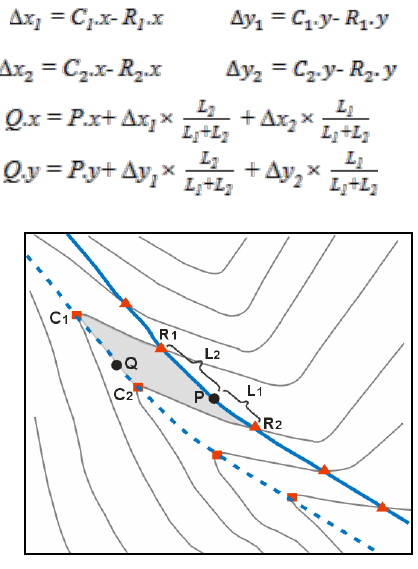
Figure 6. The displacement of river network to match contour